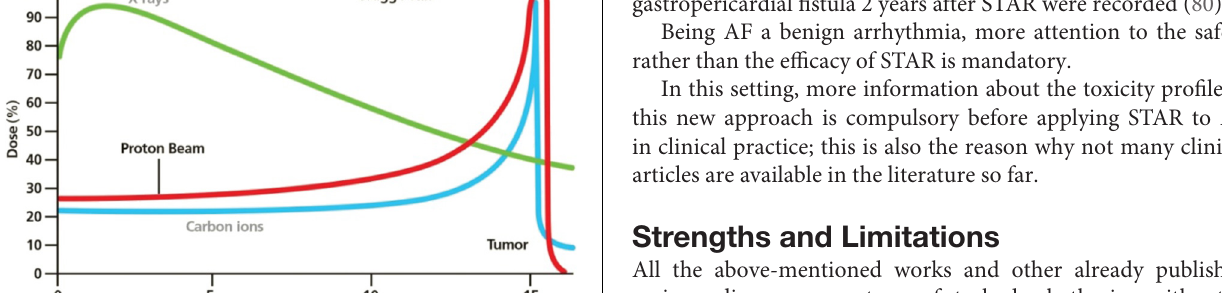
rescanning and 4D dose calculation (58) or the use of